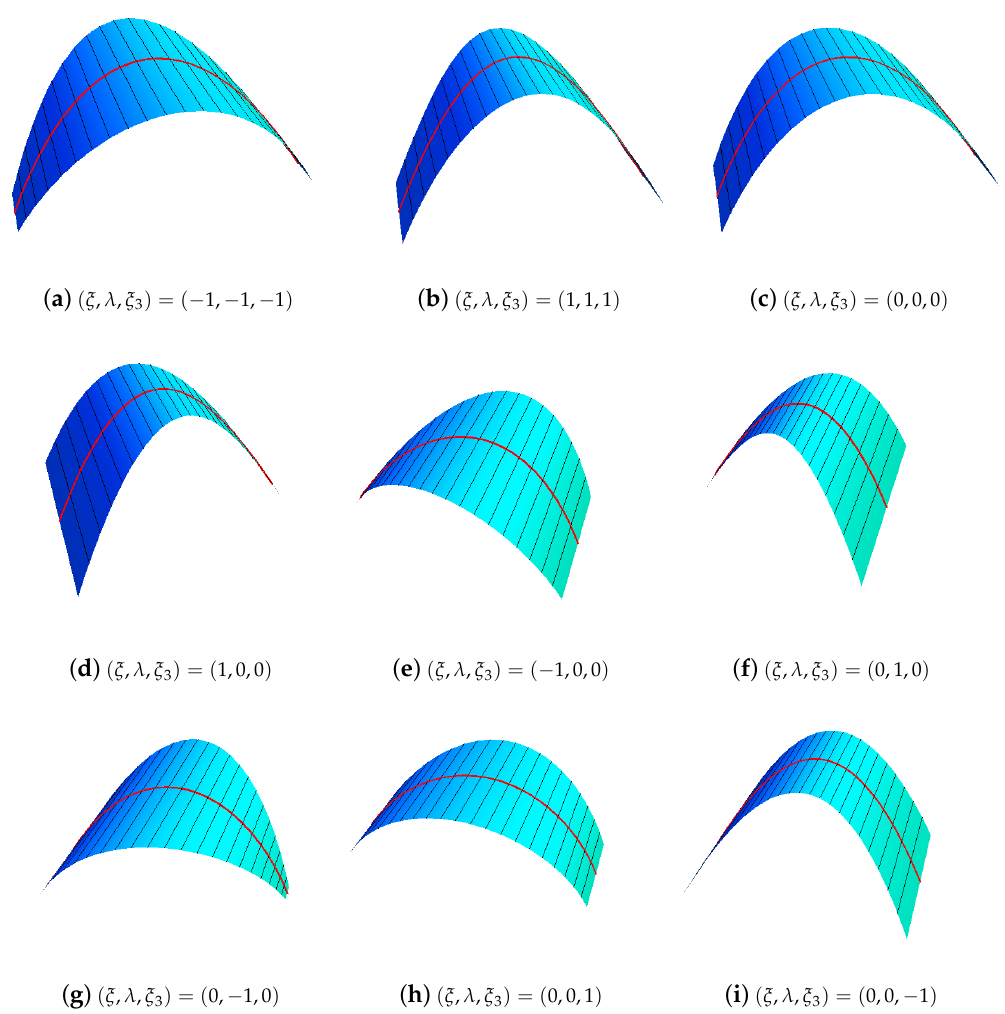
Figure 7. Surface interpolation geodesic developable GHT-Bézier surfaces having different values of ξ 1 , λ , ξ 3